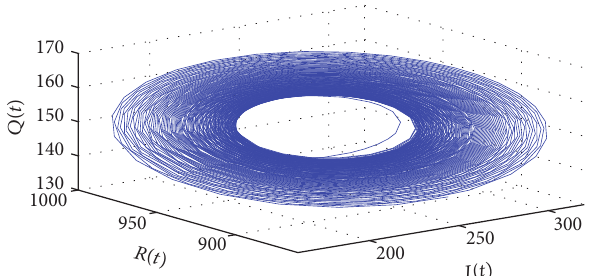
Figure 16: The projection of the phase portrait of system (69) in (𝐼, 𝑄, 𝑅) -space with 𝜏